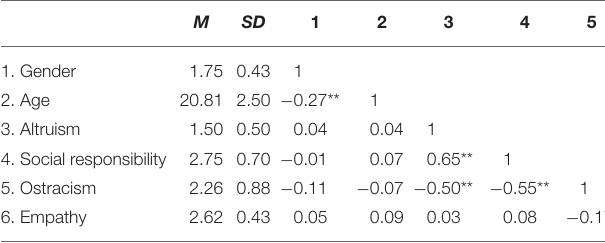
TABLE 2 | Means and standard deviations of the variables in study